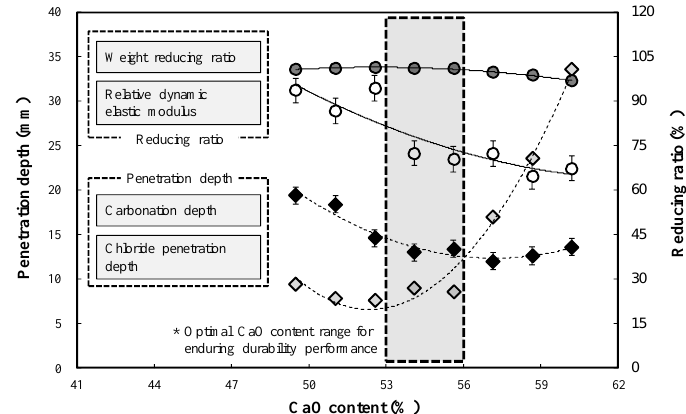
Figure 16. Optimal CaO content range for enduring durability performance.